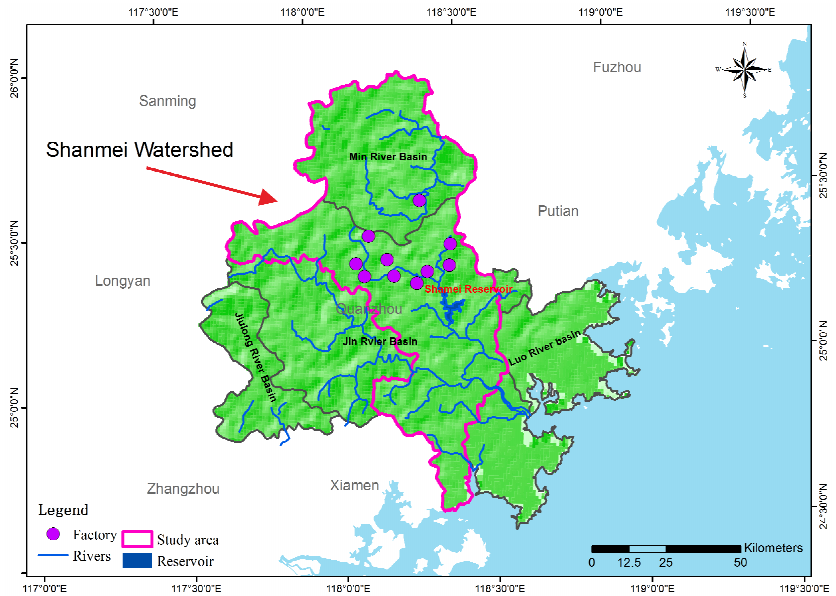
Figure 1. Sketch map of the study area.